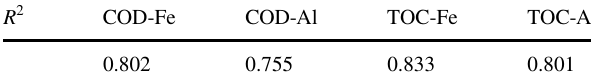
Table 2 Multi determination